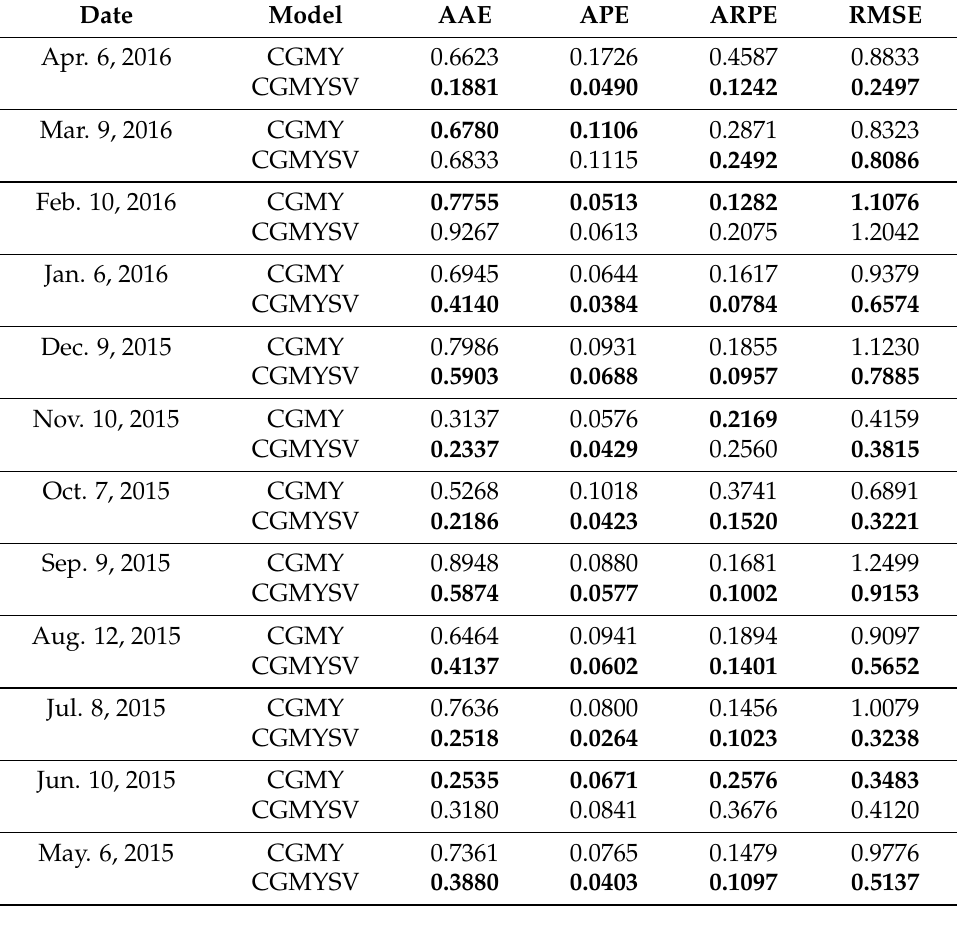
Table 6. Error Estimates for the calibration of the OEX option.